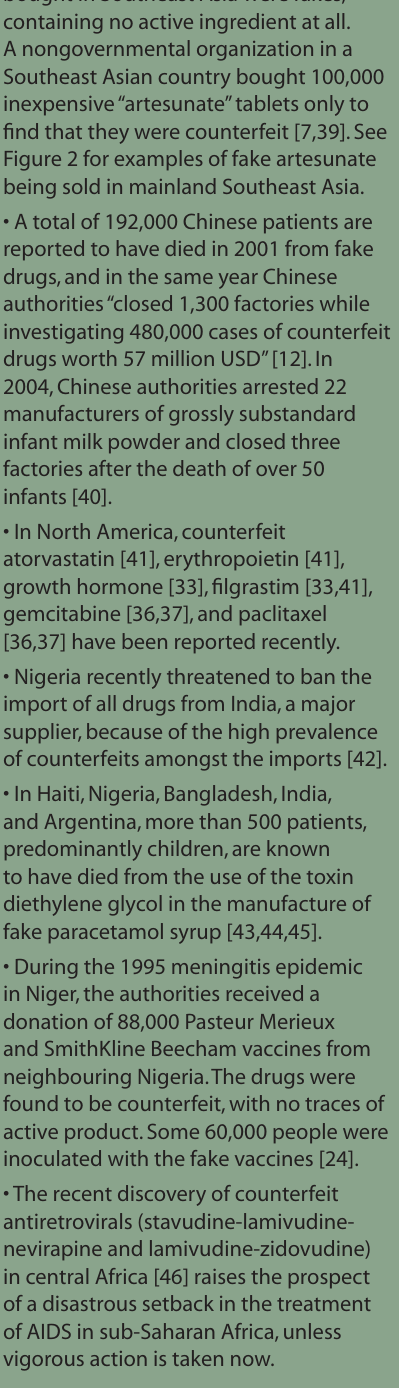
Figure 2 for examples of fake artesunate being sold in mainland Southeast